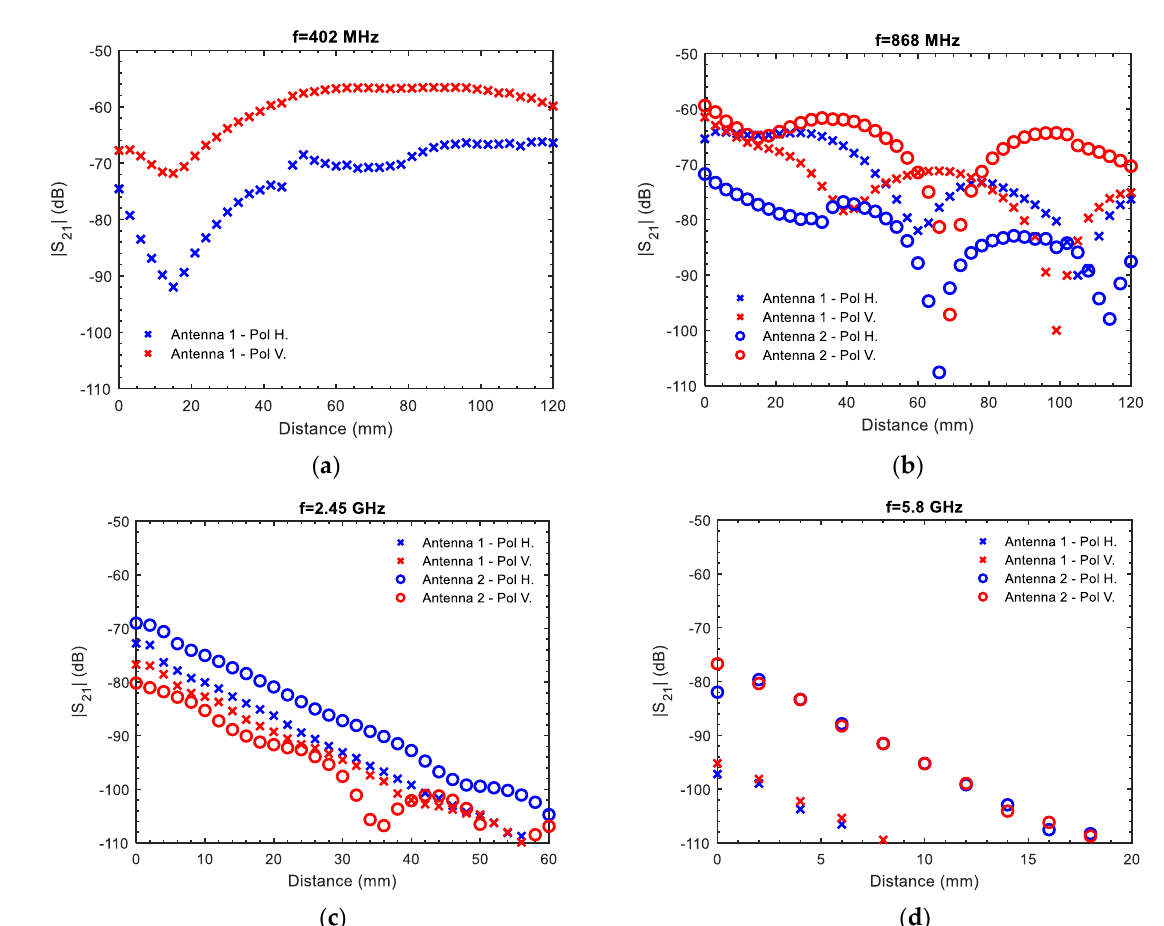
Figure 8. S 21 dB vs. distance for the different antennas and polarizations: ( a ) f = 402 MHz, ( b ) f = 868 MHz, ( c ) f = 2.45 GHz and ( d ) f = 5.8 GHz.